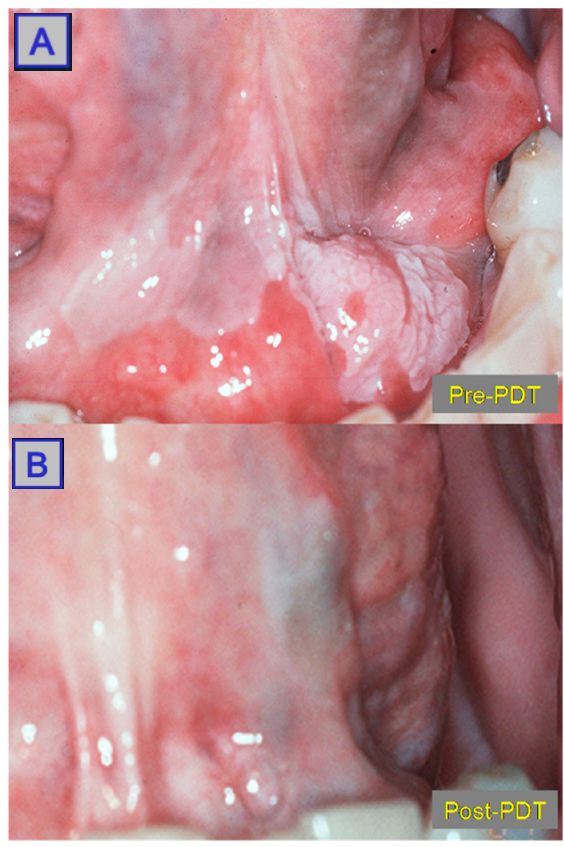
Figure 10. Images showing an oral squamous cell carcinoma pre-PDT ( A ) with superficial tissue changes. Post-PDT ( B ) showing significant tissue regeneration, indicating a positive response to treatment. Reprinted with permission from ref. [36]. Copyright 2011 Lasers Surg. Med.